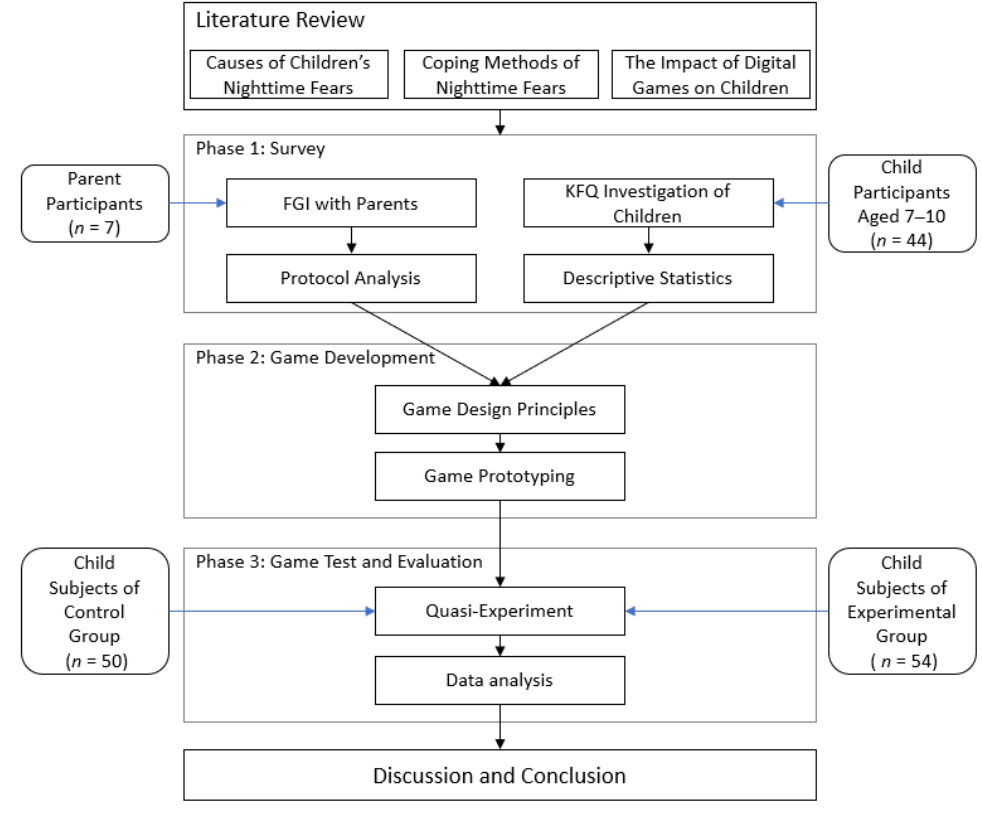
Figure 1. Research phase flow chart.